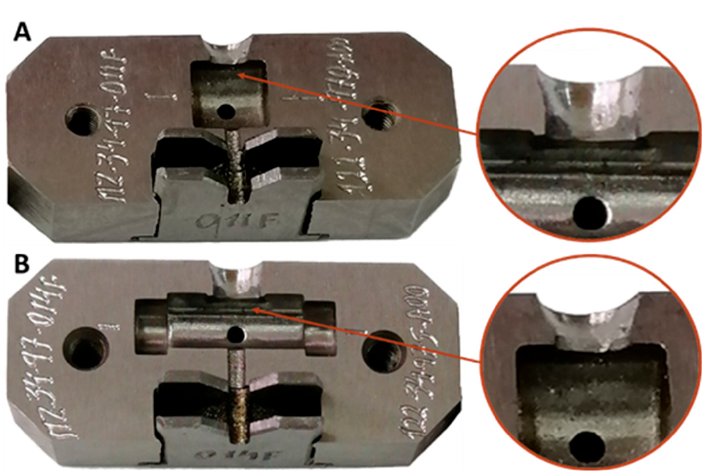
Figure 18. Gating system, after modification, for terminal of model 75 ( A ) and model 70 ( B ).